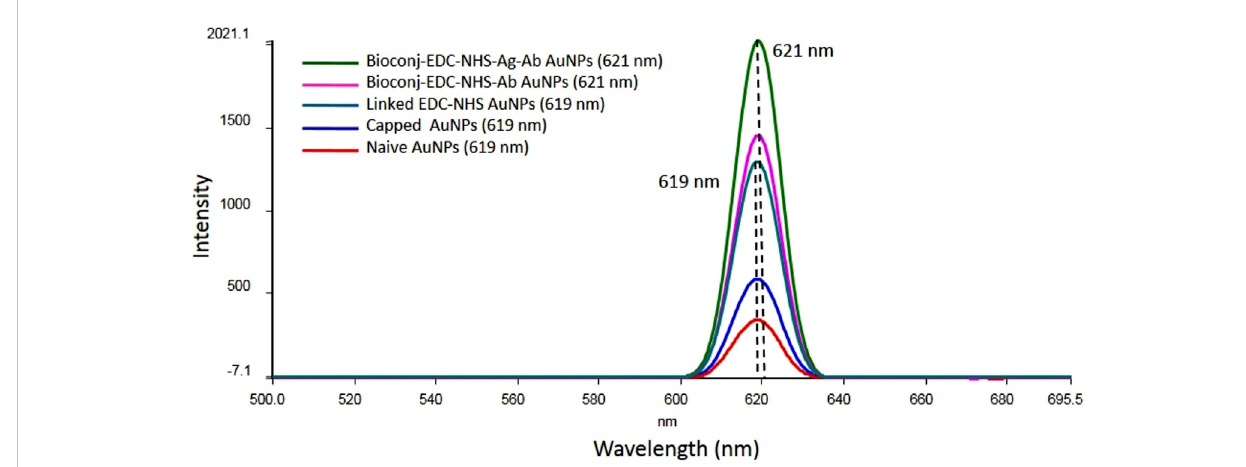
FIGURE 8 Fluorescence spectroscopy analysis of AuNPs showing the characteristic shift and an increase in the intensity of the absorption spectrum related to thesurfaceplasmonresonanceofnaive,capped,linked,andbioconjugatedAuNPs(bioconjugated-EDC-NHS-Abandbioconjugated-EDC-NHS-Ag-Ab) with the corresponding peak shift from 619 nm to 621 nm. The increase in the intensity of the absorption maximum during step-by-step AuNP modi fi cation indicated selective detection of particles with a particular size and shape.